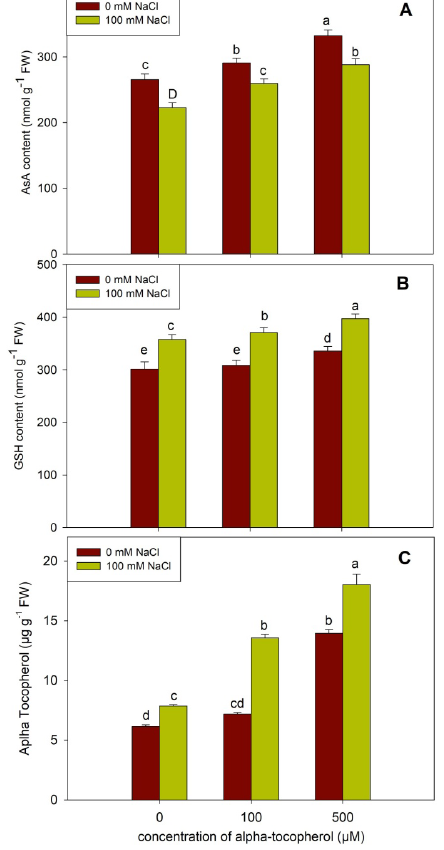
Fig. 3: Effect of increased salinity (100 mM NaCl) stress with and without exogenous application of-tocopherol (100 and 500 μM) on the ac - tivity of (A) superoxide dismutase (SOD), (B) ascorbate peroxidase (APX) and (C) glutathione reductase (GR) in soybean ( Glycine max ). Values are mean (±SE) of five replicates and different letters repre - sent significant difference at